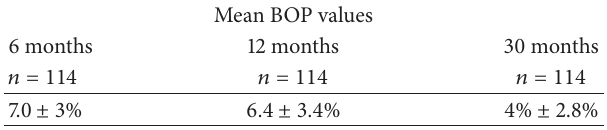
Table 4: Mean BoP values in % ( 𝑛 : number of implants). Mean BOP